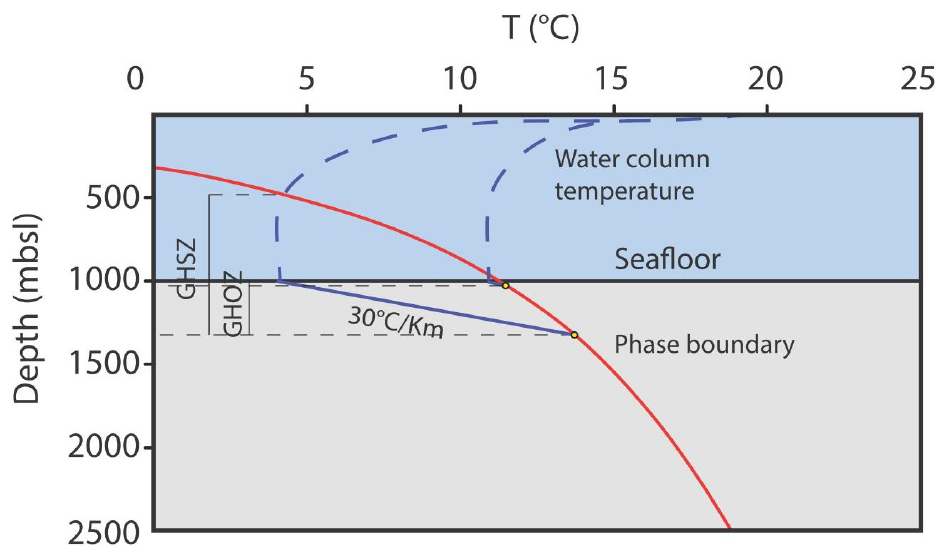
Figure 8. Evaluation of the gas hydrate stability along the northern Apennines in the Miocene, based on the assumptions reported in the text. For bottom water temperature of 4 °C, gas hydrates would be stable for 400 m below the seafloor. The value of 11 °C represents the highest temperature allowing the occurrence of gas hydrates in the upper tens of meters of sediments. Water column profiles were drawn following [48].